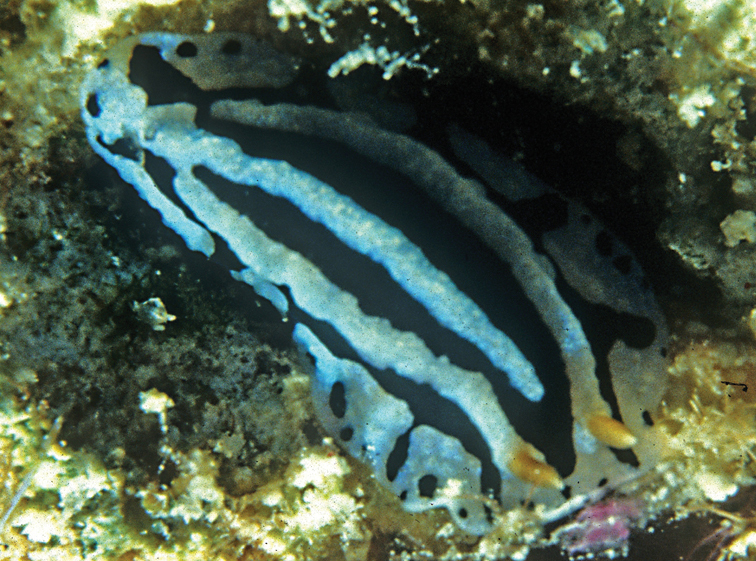
Phyllidiopsis sphingis, 17 mm, Maldives, photo: S Harwood.